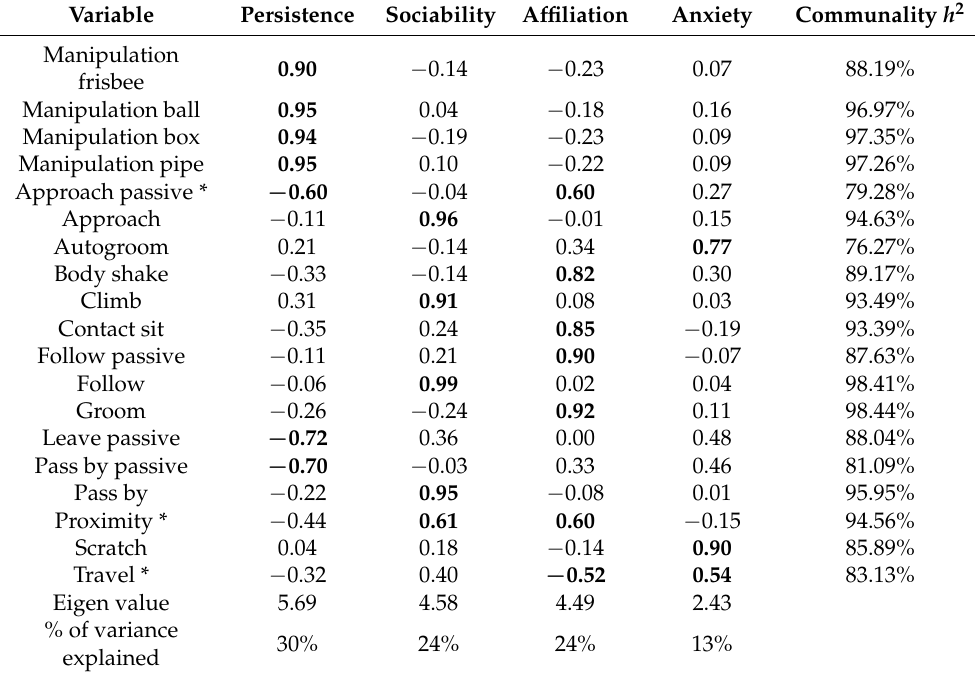
Table 2. Variable loadings in the principal component analysis.